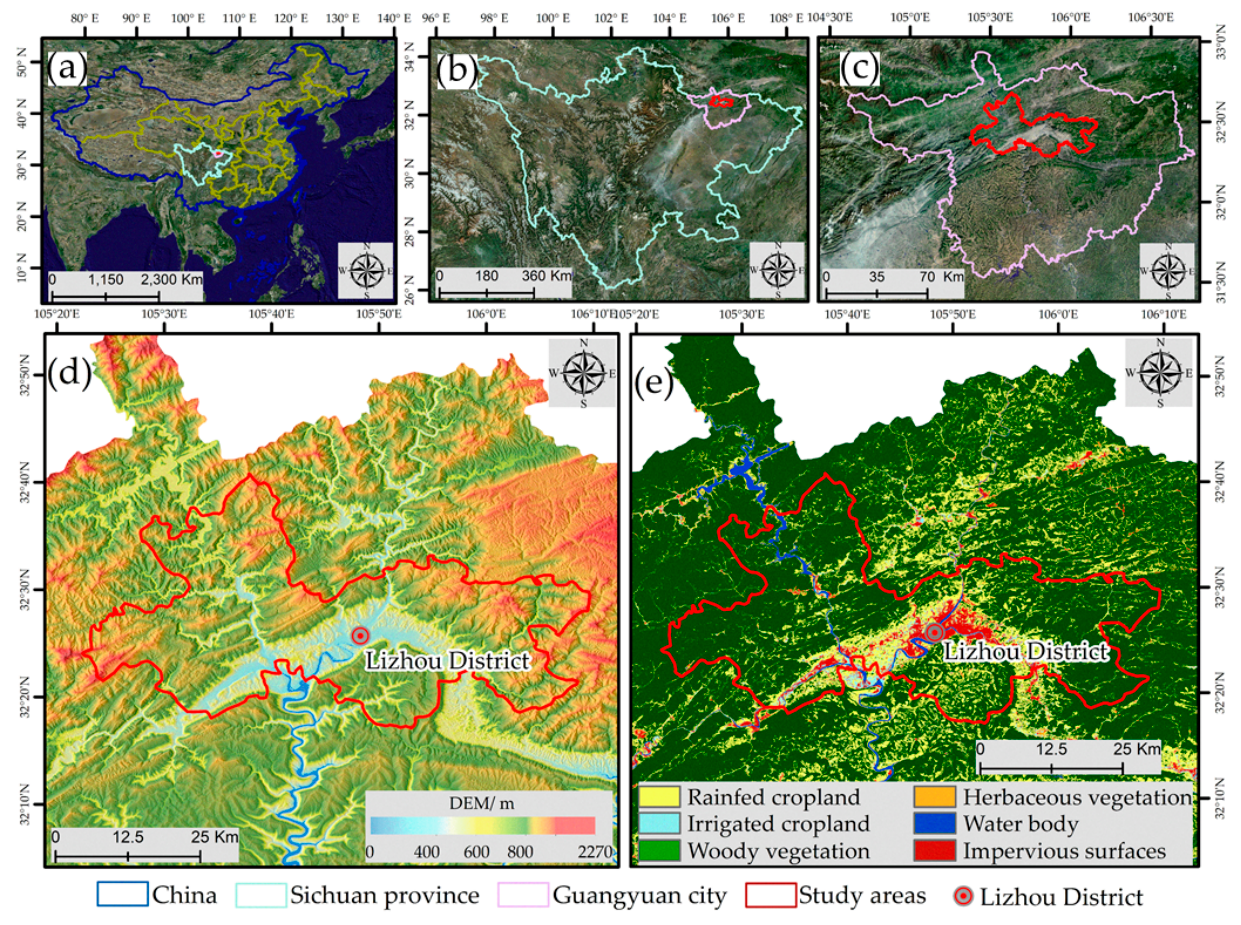
Figure 1. ( a ) The location of the study areas in China; ( b ) the location of the study areas in Sichuan provinces; ( c ) the location of the study areas in Guangyuan city; ( d ) NASA SRTM digital elevation 30 m; ( e ) reclass map of GLC_FCS30 in 2020. Table 1. Band information of Sentinel-1 and